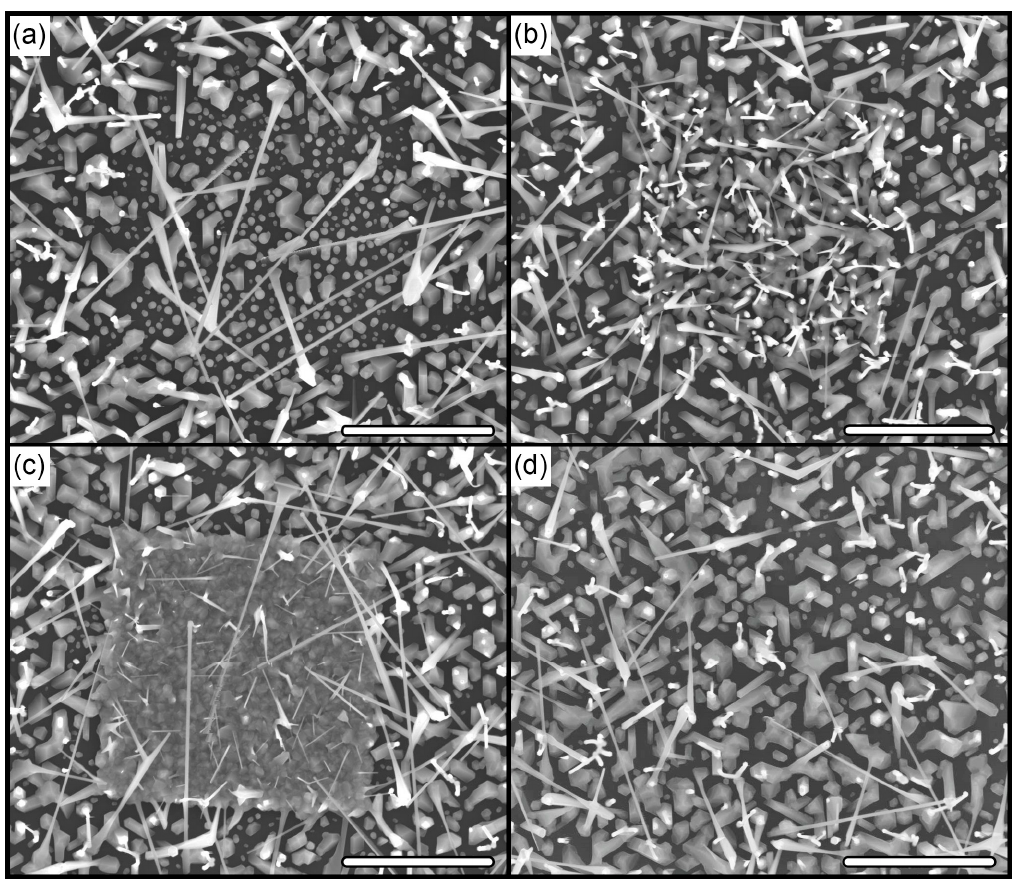
Figure 1. SEM images (view from above) of modified areas with Ga ion dose of 0.052 ( a ), 0.26 ( b ), 10.4 ( c ) pC/µm 2 , and unmodified area ( d ) after GaAs NW growth. Scale bar is 3 µm. Area II—medium ion dose values (from ~ 0.1 pC/µm 2 to ~ 1.0 pC/µm 2 ). An increase in